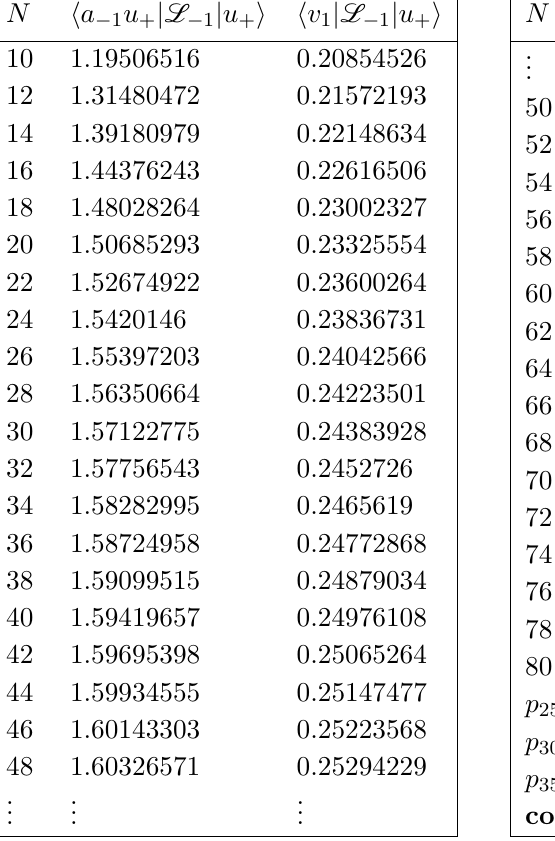
Table 7 . Matrix elements of L (cid:6) 1 and (cid:22) L (cid:6) 1 in the sector of S z = 1, at x = (cid:25) , with the same conventions as in table 3. In this table e = 1 is considered again. Polynomial extrapolations p n (1 =N ) of degrees n = 25 ; 30 ; 35 to all the data points are made in order to approximate the value at N ! 1 . As discussed in section C.1, the state j v 2 i is not included here. The resulting additional factor of 1 p has been taken into account in the 2